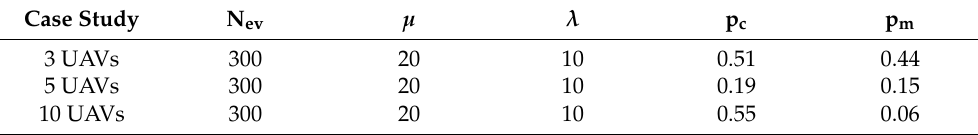
Table 2. Parameterisation of the proposed EA for each case study obtained by irace. Case